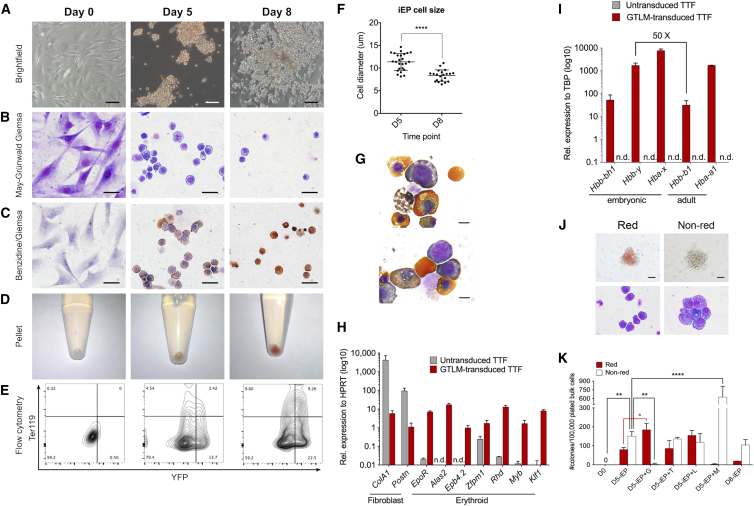
Induced Erythroid Progenitors Exhibit Properties of Bona Fide Erythroid Cells(A–E) Time course of iEP generation of untransduced TTFs (day 0) and bulk GTLM-transduced TTFs on days 5 and 8 (representative of n = 2–3). Transdifferentiation was evaluated by (A) live-cell, bright-field images of single wells (scale bar, 50 μm); (B) May-Grünwald-Giemsa staining cytospin (scale bar, 20 μm); (C) benzidine/Giemsa staining cytospin (scale bar, 20 μm); (D) macroscopic inspection of cell pellets; and (E) representative flow cytometry plots showing YFP/Ter119 expression.(F) Cell diameter of iEPs harvested on days 5 and 8 measured by CellSens Standard 1.6 software from several cytospin slides, showing a decrease in cell size on day 8. Data are presented as mean ± SD (n = 21–25). ∗∗∗∗p ≤ 0.0001.(G) Representative high-resolution benzidine/Giemsa cytospin images of GTLM-transduced TTFs on day 8. Scale bar, 5 μm.(H and I) Relative mRNA expression of (H) relevant erythroid and fibroblast-specific genes and (I) globin genes in bulk GTLM-transduced TTFs (red columns) versus untransduced TTF (gray columns) on day 8, determined by qPCR. Data are presented as mean ± SD (n = 4–6 for iEPs, n = 2 for untransduced TTFs).(J) Representative bright-field and May-Grünwald-Giemsa cytospin images of iEP-derived red and non-red colonies.(K) Colony counts generated from plated untransduced TTFs, bulk day 5 iEPs, bulk day 8 iEPs and bulk day 5 iEPs generated by doubling the ratio of each of the GTLM factors. Scale bars, 50 μm (colony images) and 20 μm (cytospin images). Data are presented as mean ± SD (n = 3). ∗∗p ≤ 0.001; ∗∗∗∗p ≤ 0.0001.See also Figure S2.